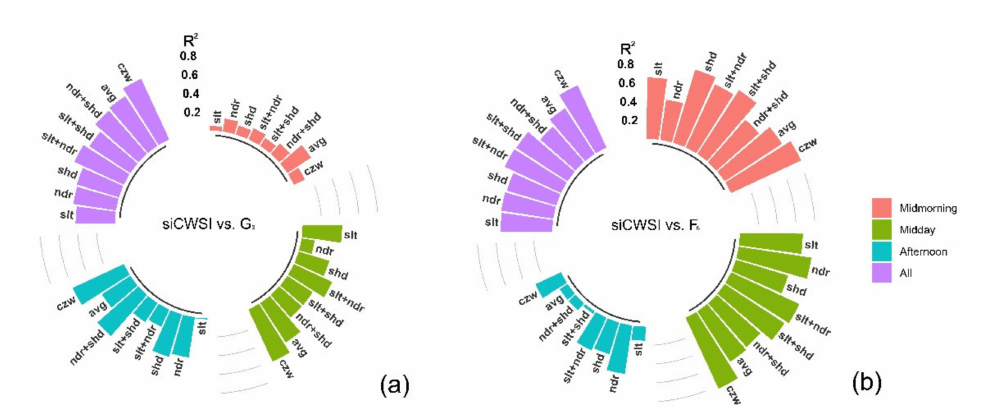
Figure 11. Circular bar plots show the relationships (R 2 ) established between siCWSI from di ff erent canopy zones and stomatal conductance (G s , ( a )) and steady-state fluorescence (F s , ( b )) for the three thermal flights on 15 September 2017 and all three flights combined. slt is for sunlit canopy zone, ndr is for nadir canopy zone, shd is for shaded canopy zone, avg is for average value of entire canopy zone, and CZW is for canopy zone-weighting